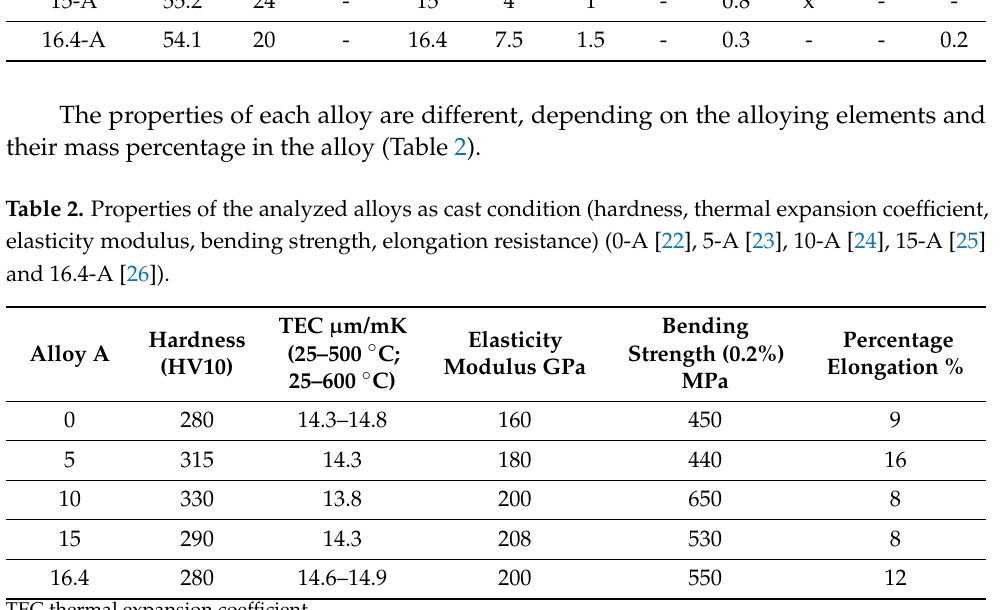
Table 2. Properties of the analyzed alloys as cast condition (hardness, thermal expansion coefficient, elasticity modulus, bending strength, elongation resistance) (0-A [22], 5-A [23], 10-A [24], 15-A [25] and 16.4-A [26]).